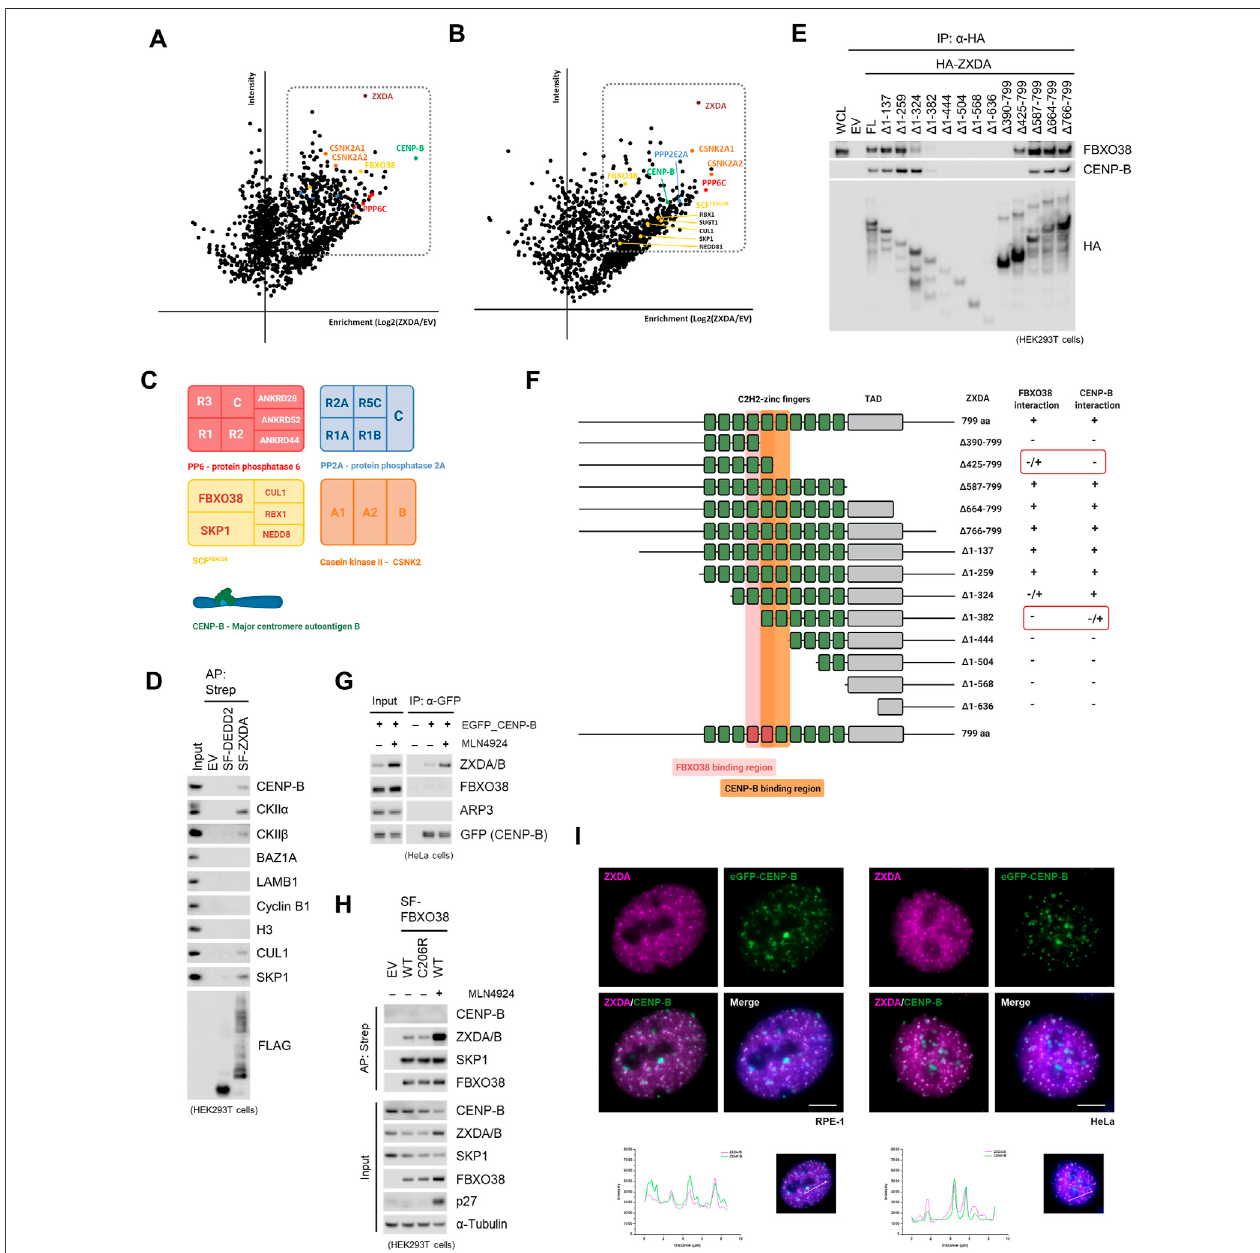
FIGURE 5 | ZXDA/B are CENP-B associated proteins. (A) Schematic representation of mass-spectrometry identi fi cation of ZXDA-interacting proteins. Af fi nity- puri fi ed proteins from HEK293T cells expressing StrepII-FLAG-tagged ZXDA (SF-ZXDA) were identi fi ed by Liquid Chromatography with Tandem Mass-Spectrometry (LC-MS/MS). Proteins that were signi fi cantly enriched in ZXDA puri fi cations compared to the controls are highlighted in box. The graph represents maximum intensity and the enrichment calculated from ratio of intensities of identi fi ed proteins. Colors represent the identity of proteins to different complexes as it is depicted in (C) . (B) Schematic representation ofmass-spectrometry identi fi cation ofZXDA-interacting proteins. Af fi nity puri fi edproteins fromHeLacellswithinducibleexpression ofSF- ZXDA were identi fi ed by LC-MS/MS as in (A) . (C) Schematic composition of proteins and protein complexes enriched in ZXDA interactome from (A) and (B) . (D) HEK293TcellsweretransfectedwithSF-taggedZXDAorDEDD2,andwhole-celllysatesweresubjectedtoaf fi nity puri fi cation(AP)andsubsequentlyimmunoblottedas indicated. An empty vector (EV) was used as a negative control. The input represents 1% of the lysate subjected to AP. (E) HEK293T cells were transfected with HA- tagged full-length (FL) ZXDA or its deletion variants. Cells were treated with the MLN4924 inhibitor 6 h prior to collecting. Whole-cell lysates (WCL) were subjected to immunoprecipitation (IP) using anti-HA beads. Empty vector (EV) was used as a negative control. (F) Schematic representation of full-length ZXDA (1 – 799 aa) or its N- andC-terminallytruncatedvariants.Zinc fi ngersaredepictedasgreenboxes,thoseessentialforinteractionwithFBXO38arered-tinted,withCENP-Bareorange-tinted. ThemiddlepanelindicatesdeletedaminoacidpositionsinZXDA.Interactingvariantsareindicatedbythesymbol(+)(+/-)denotesreducedbinding,and(-)denotesalack ofbinding.TAD;transcriptionalactivationdomain. (G) HeLacellsexpressingeGFP-CENP-BweretreatedwithMLN4924for6 hwhereindicated.Solubleproteinfraction ( Continued )